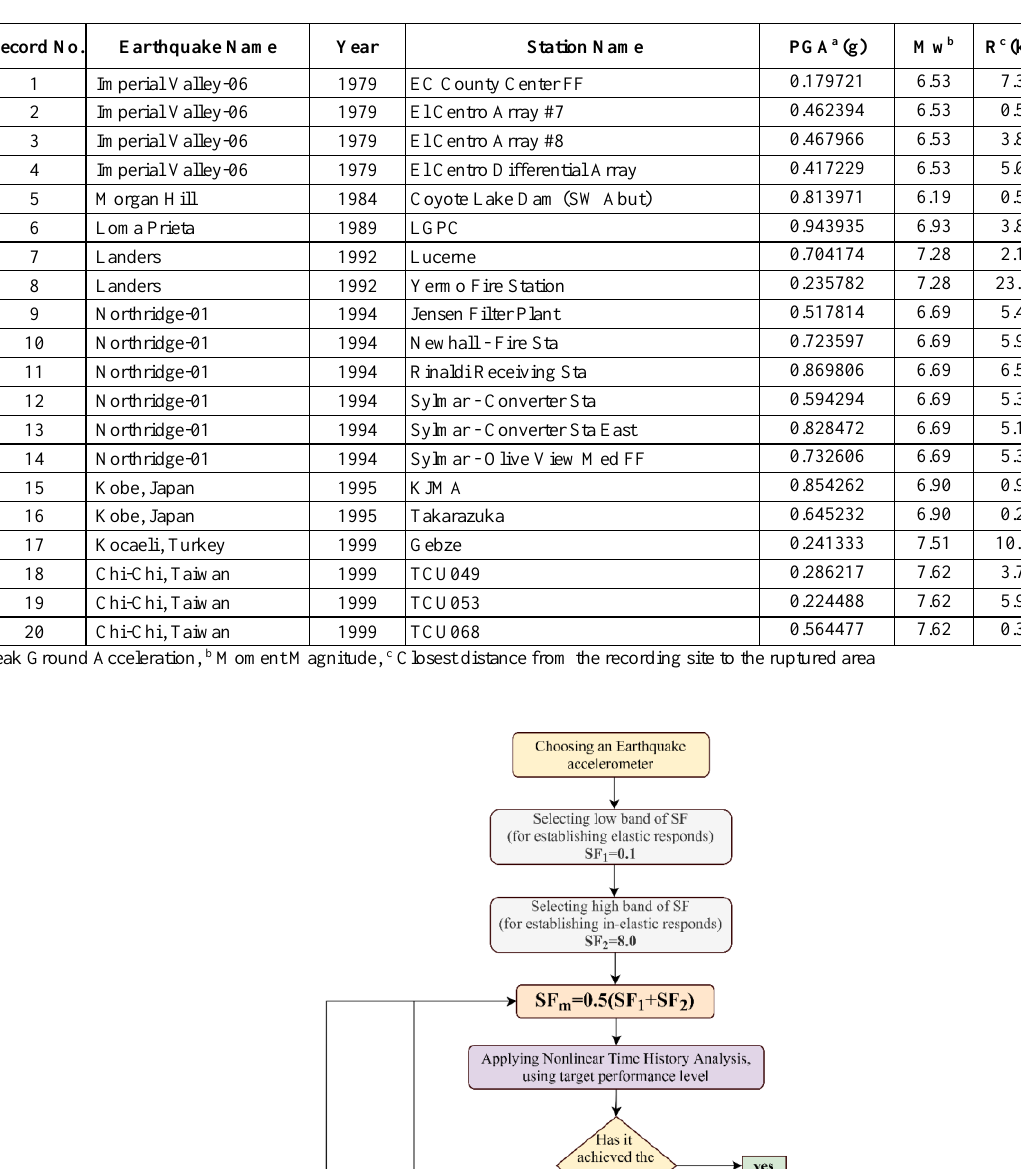
Table 1. Characteristics of near-fault earthquakes applied in the study